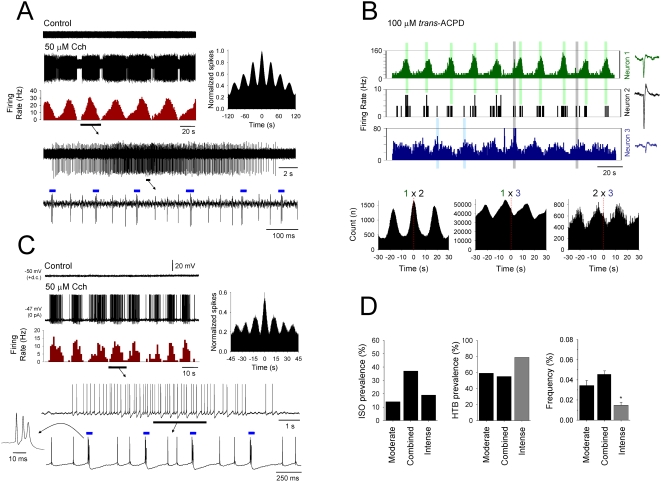
Appearance of a population ISO in TC neurons following moderate activation of AchRs and/or mGluRs.A. Application of of 50 µM Cch induces spontaneous firing in a TC neuron that is modulated by an ISO at ∼0.03 Hz (second trace from top). The corresponding auto-correlogram and firing rate histogram are shown to the right and immediately below, respectively. Shown further below are enlarged sections from one of the firing episodes, as indicated, which reveal a mixture of tonic firing and HT bursts (blue bars). B. Firing rate histograms from three distinct, simultaneously recorded VB TC neurons (respective spike waveforms are shown to the far right) showing an ISO at ∼0.05 Hz in the presence of 100 µM trans-ACPD (See also Fig. S1). Note how the firing of neuron 3 (bottom plot, blue bars) generally peaks before that of neuron 1 (top plot, red bars) but that neuron 2 (middle plot, grey bars) seems to be directly linked by both cells (light red and light blue bars). The plots below show the respective cross-correlograms for the 3 possible neuron-neuron combinations as indicated. C. Intracellular recording of an LGN TC neuron which exhibits an ISO at ∼0.075 Hz following 50 µM Cch application. The corresponding auto-correlogram and firing rate histogram are shown to the right and immediately below, respectively, and enlarged sections are shown further below, as indicated (HT bursts indicated by blue bars). D. Histograms summarizing the effect of moderate (100 µM trans-ACPD or 50 µM Cch), combined (100 µM trans-ACPD and 50 µM Cch) and intense (200 µM trans-ACPD or 100 µM Cch) agonist application on ISO prevalence (left), percentage of ISOs involving HT bursting (middle) and ISO frequency (right).